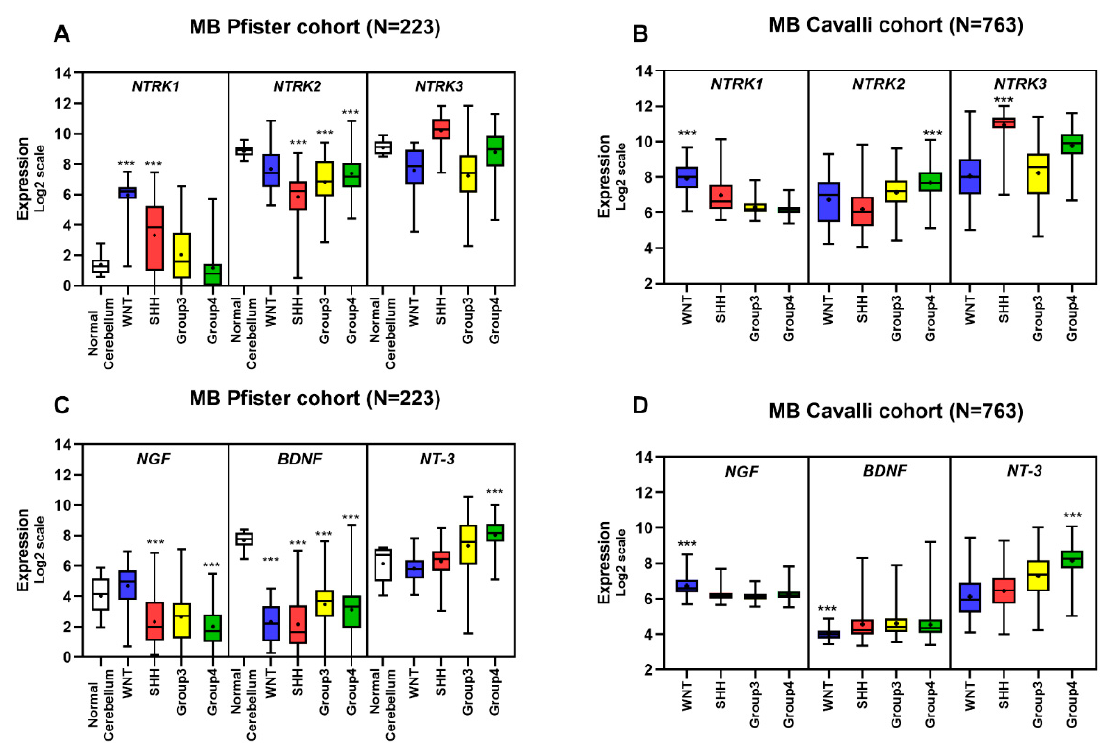
Figure 3. Transcript levels of neurotrophins and their receptors in tumors across the 4 MB molecular variants compared to expression in normal human cerebellum. Expression levels were examined in previously described transcriptome data sets comprising samples from Pfister ( n = 223 MB samples; [22]), Roth ( n = 9 normal cerebellum samples; [11]), and Cavalli et al. [15] ( n = 763 MB samples). Expression of NTRKs ( A , B ) and neurotrophins ( C , D ) across all samples is presented in boxplot format as log2-transformed signal intensity. All subgroups were compared using a Kruskal–Wallis test followed by the False Discovery Rate method. Data are shown as median and whiskers: min to max. Statistical differences in comparison to normal cerebellum are shown in panels A and C, and differences between all subgroups in panels B and D; *** p ≤ 0.001 for significance.